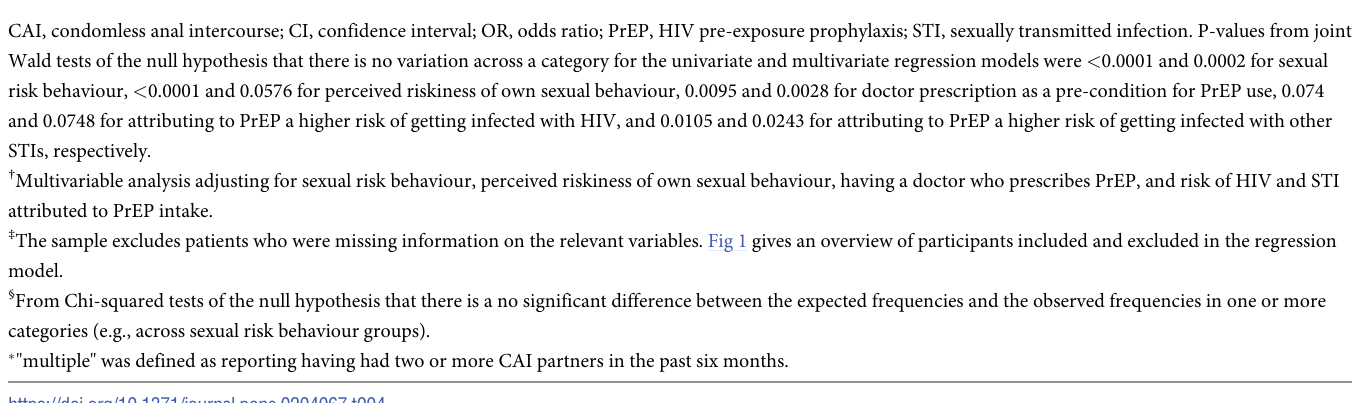
Table 4. ORs and 95% CIs for expressing a desire to use PrEP, by sexual risk behaviour, perceived riskiness of own sexual behaviour, and barriers and risks attrib- uted to PrEP intake. Participant